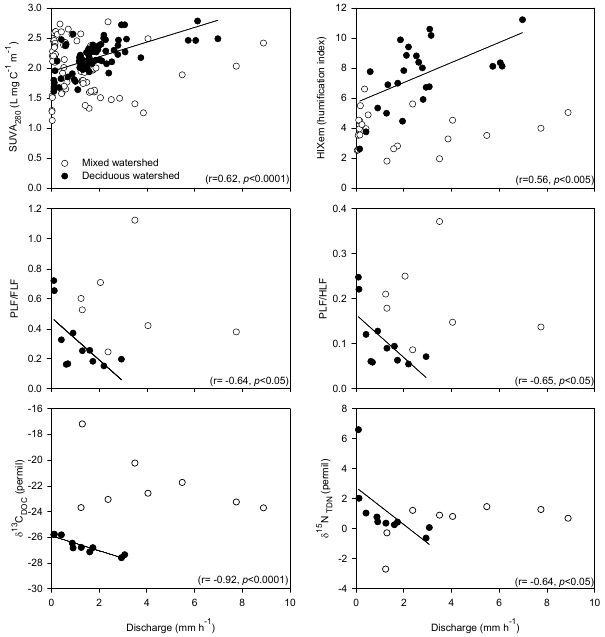
Figure 5. Specific ultraviolet absorbance (SUVA 280 ) , humifica- tion index (HIXem), protein-like fluorescence/humic-like fluo- rescence (PLF/HLF), protein-like fluorescence/fulvic-like fluores- cence (PLF/FLF), 13 C isotope abundance of dissolved organic car- bon ( δ 13 C DOC ) , and 15 N isotope abundance of total dissolved ni- trogen ( δ 15 N TDN ) in runoff with discharge during monsoon storm events. Only significant regressions are shown.